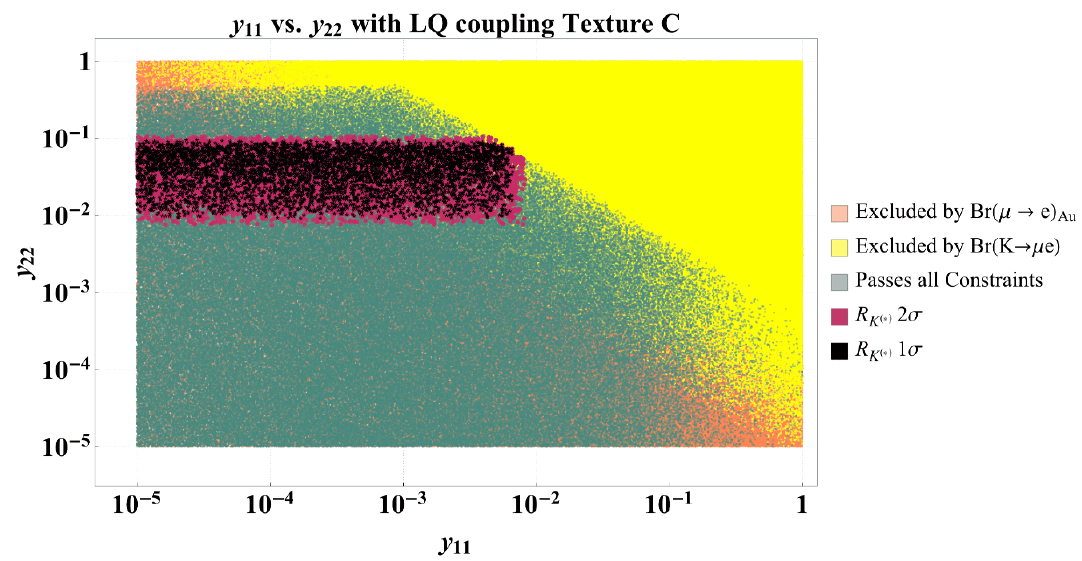
Figure 20 . Indicative plot of the allowed parameter space in the y 22 vs. y 11 plane, for leptoquark coupling matrix Texture C. The yellow section is ruled out by Br( K ! (cid:22)e ), the orange section is ruled out by Br( (cid:22) ! e ) Au , while the teal region is allowed parameter space; speci(cid:12)cally it passes all constraints discussed in section 3 as well as perturbativity constraints on the diquark coupling constants z LL 1 ij